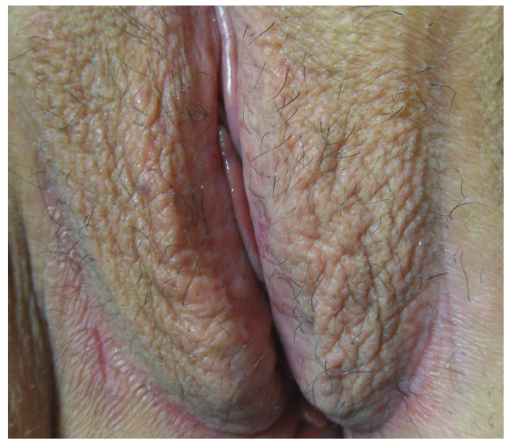
Figure 1: Lichenification on the vulvar region.